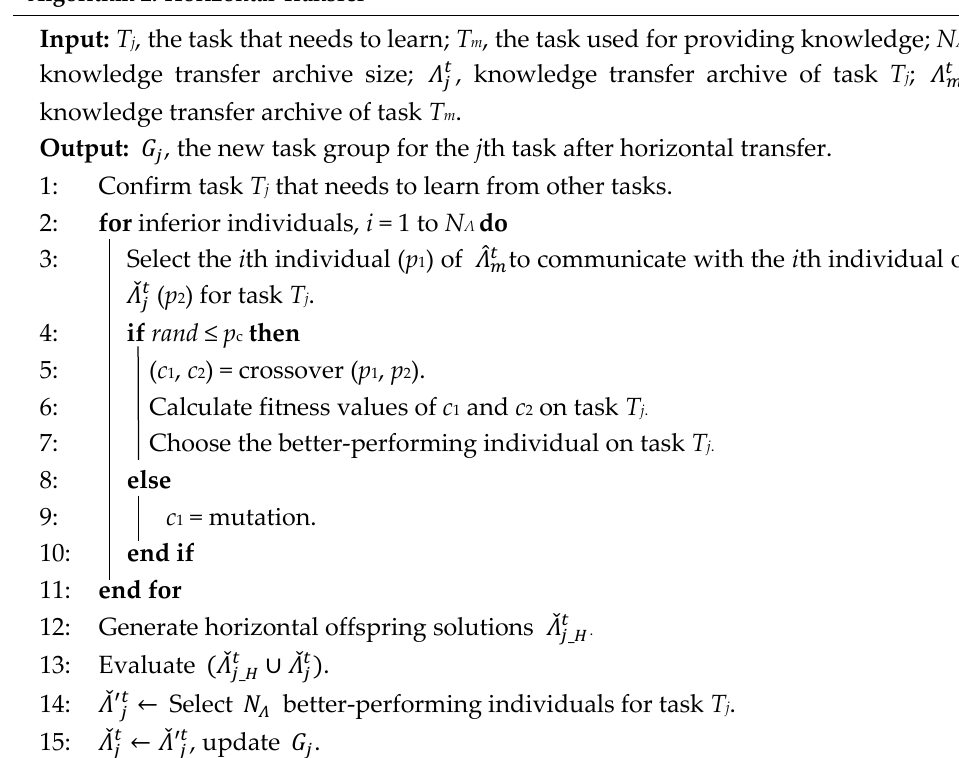
Algorithm 2. Horizontal Transfer